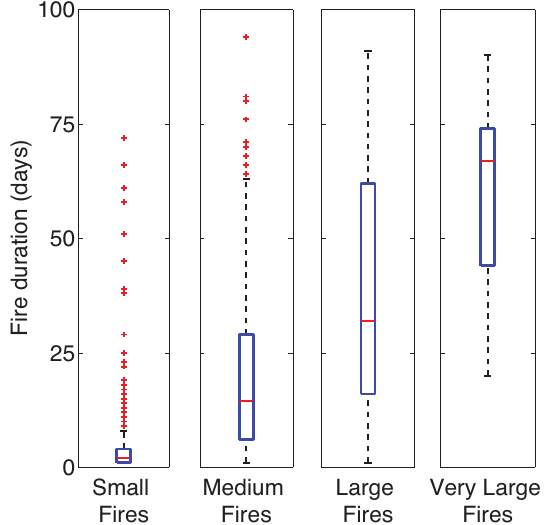
Figure 4. Relationship fire duration and fire size: Small fires were defined as having sizes between (0–1000ha, medium fires between 1000–10000ha, large fires between 10000–50000)ha, and very large fires as greater than 50000ha. The percentage of number of fires and burned area for each group was respectively 63.5% and 2% for small fires; 24.3% and 18% for medium fires; 10% and 39.9% for large fires; and 2.7% and 40% for very large fires.